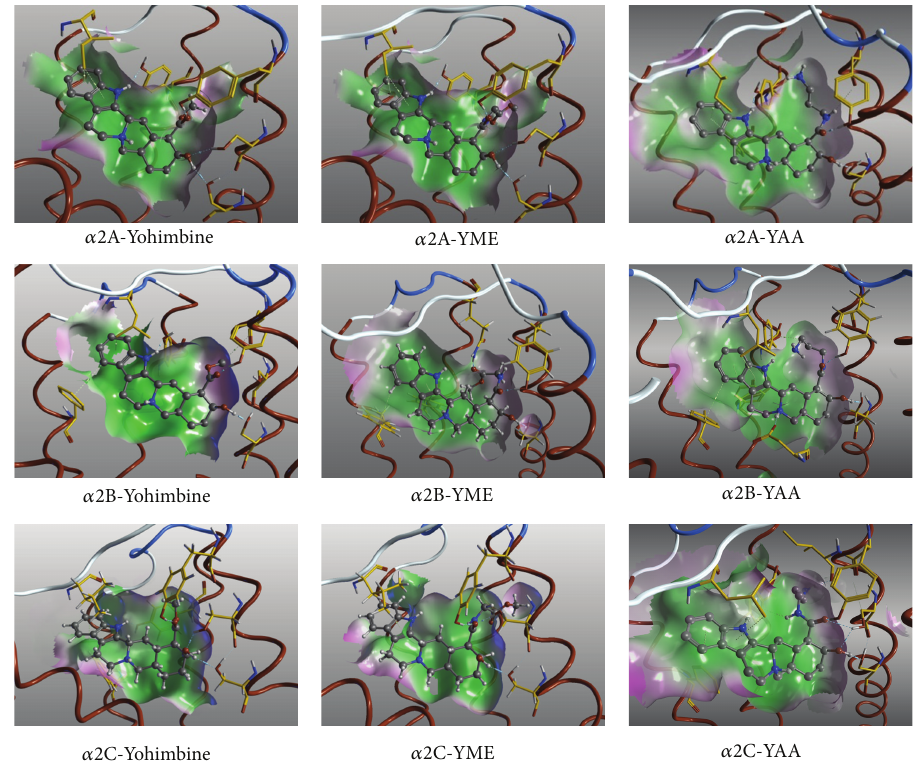
Figure 6: The pose of 3 ligands in the binding pocket of 3